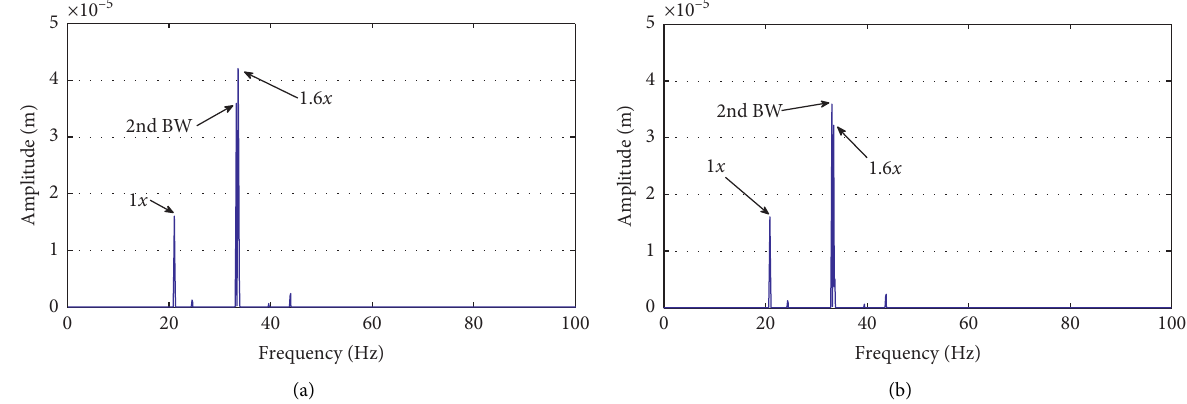
Figure 9: Spectrum of out-of-balance at bearing 1 (inner rotor): (a) horizontal direction and (b) vertical direction.